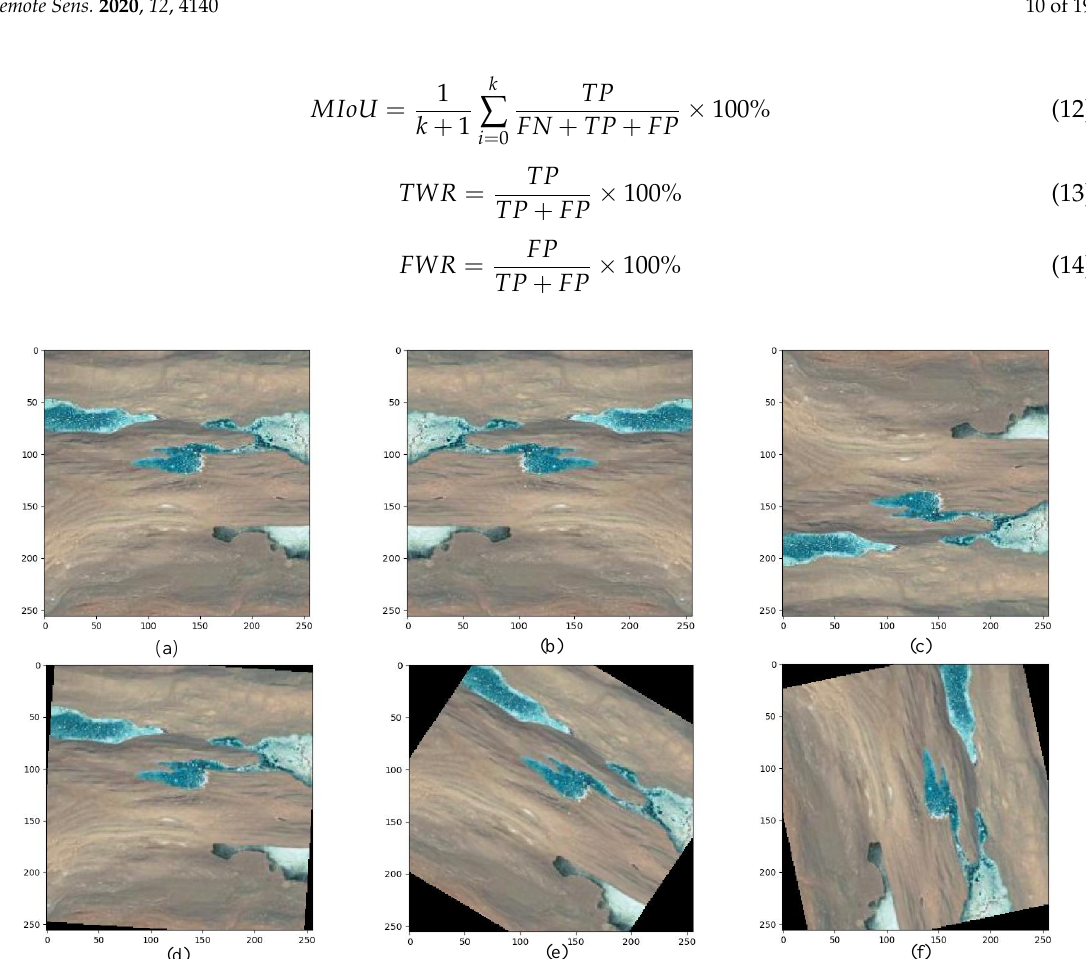
Figure 6. Examples of data augmentation. ( a ) is the original image; ( b ) is flipping the original image left and right; and ( c ) is flipping the original image up and down. ( d – f ) is rotating the original image at any angle of (0 ◦ , 90 ◦